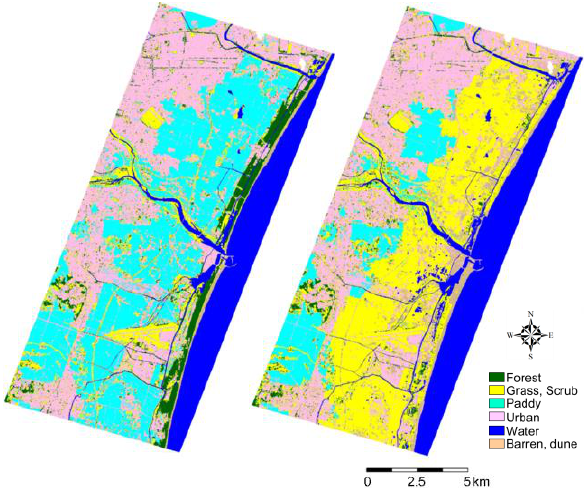
Figure 4(b). Results of land cover classification of SPOT/HRG-2 images for the Sendai Bay area, before (left: 2 nd September 2010) and after (right: 2 nd November 2011) the disaster.